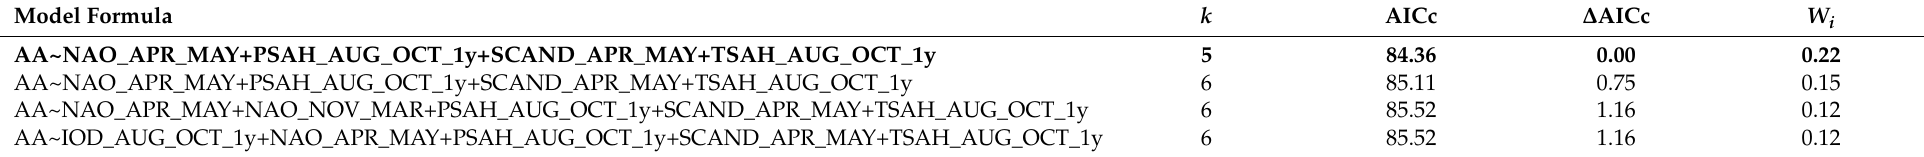
Table A19. Model selection procedure by “all subsets”, according to AICc, from the full model of the relationship between the 15 climate variables and the year, and the overall timing of migration as measured by Annual Anomaly (AA) for the Blackcap Sylvia atricapilla caught at Bukowo, Poland, in 1982–2017. The table presents all models with ∆ AICc < 2. The models ranked by corrected Akaike’s Information Criteria for small samples size (AICc), k is the number of estimated parameters in the model, ∆ AICc gives the difference in AICc from the model with lowest AICc, w i is the Akaike weight. Model selection with the package MuMIn 1.43.6 (Barto´n,